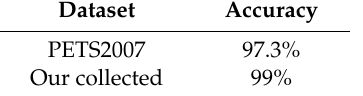
( d ) Figure 13. The result of rectangle loitering. ( a ) The rectangle loitering detection results of scenario 1. ( b ) The rectangle loitering detection results of scenario 2. ( c ) The rectangle loitering detection results of scenario 3. ( d ) The area fitting curve results of rectangle loitering, the red line in the figure indicates the threshold of the area.